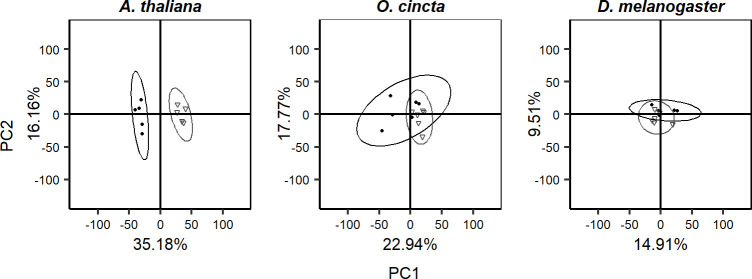
PCA scores for analysis on individual species.PCA scores plot for A. thaliana, O. cincta, and D. melanogaster acclimated to constant (filled circles) or fluctuating (open triangles) thermal regimes. Ellipses represent 95% CI.